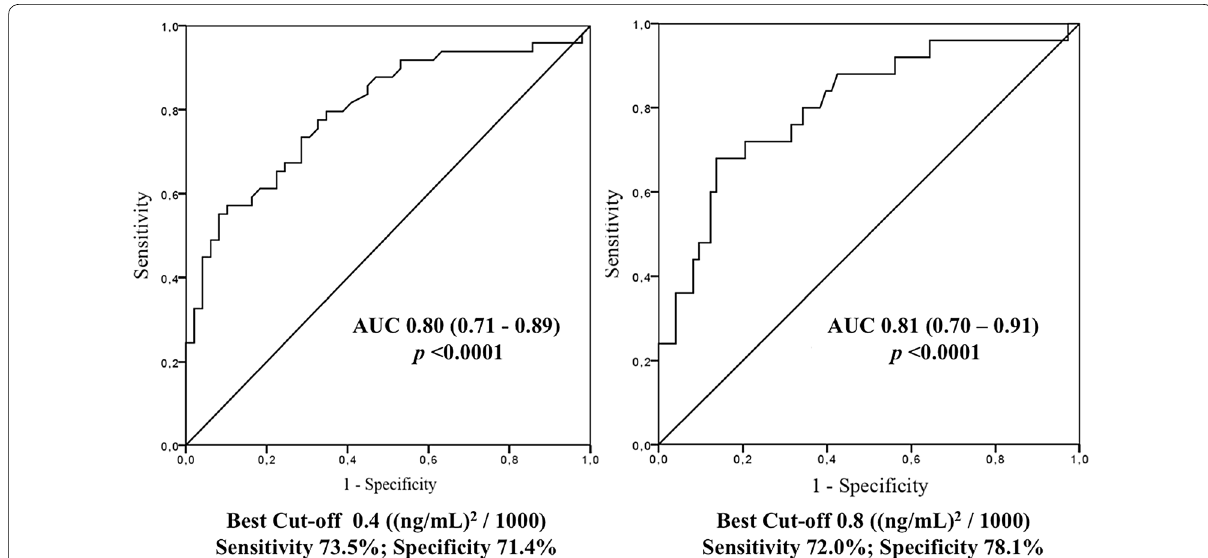
Fig. 3 ROC curve for the worst [TIMP‑2] 2] [IGFBP7] index concentration within the first 12 h of ICU admission to predict AKI ( left ) and AKIN ·